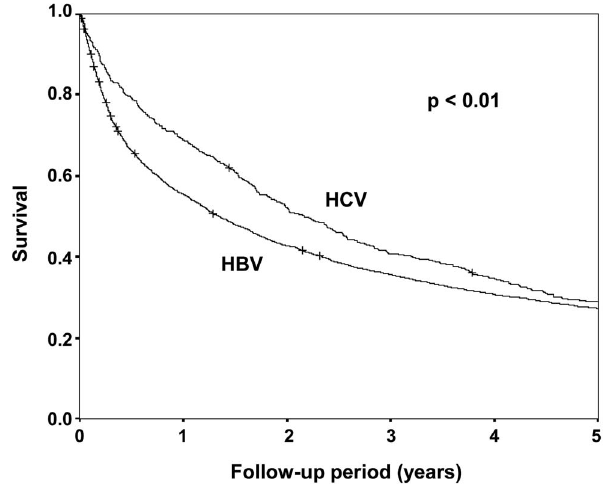
Figure 2. Long-term survival by etiology. The median survival was significantly longer in HCV-related HCC patients than in HBV-related HCC patients. (2.17 vs. 1.34 years, P , 0.01).